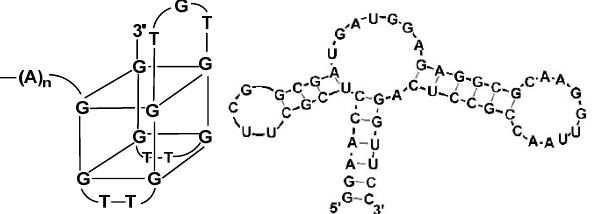
Figure 10. Examples of G4-guadruplex formed in the guanine-rich part of the aptamer molecule and pinhole aptamer.